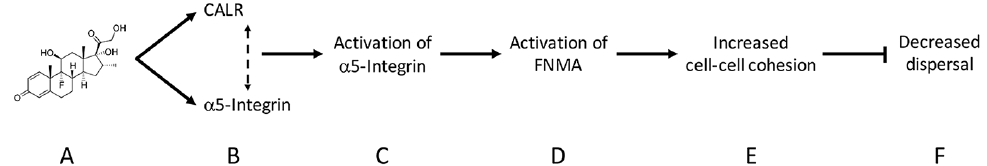
Figure 1. Scheme of working hypothesis. Dexamethasone ( A ) treatment leads to the upregulation of α 5 integrin and calreticulin (CALR), a chaperone protein for α 5-integrin that upregulates its activity either by direct interaction [4], or indirectly by phosphorylation/dephosphorylation of regulatory proteins [5] ( B ). Activation of α 5-integrin ( C ) leads to a significant increase in capacity for fibronectin matrix assembly (FNMA) ( D ), effectively “gluing” cells together. We hypothesize that restoration of FNMA by CALR will result in an increase in the strength of cell-cell cohesion ( E ), decreased cell detachment and reduced dispersal of Glioblastoma (GBM) cells ( F ). A decrease in dispersal could, in principle, keep the recurrent tumor more contained, thus rendering it amenable to localized therapy.